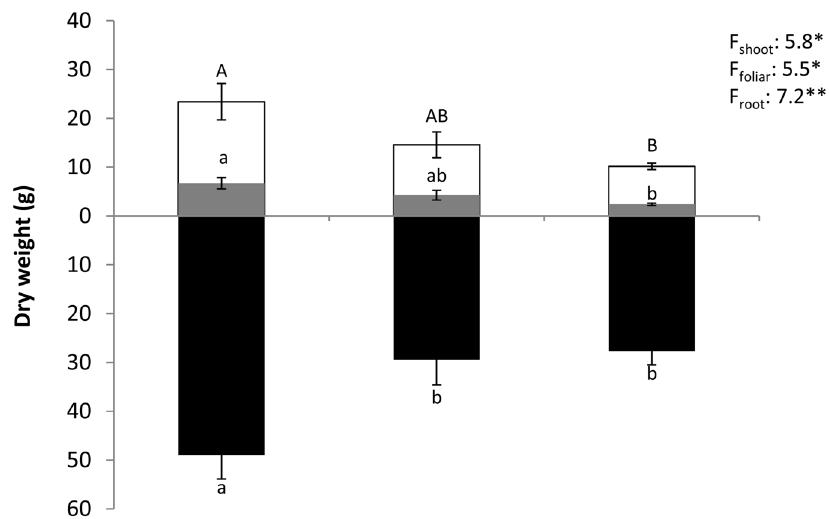
Figure 6. Biomass growth. Shoot, foliar and root biomass (g DM ind 2 1 ) during leaf senescence (in November) for control, mild and severe water stress. Differences are tested with one-way ANOVA (F). Capital black lower case black and white lower case letters denote statistical differences for shoot, foliar and root biomasses respectively with a . b or A . B given by Tukey tests. Values are mean 6 SE. n=5.